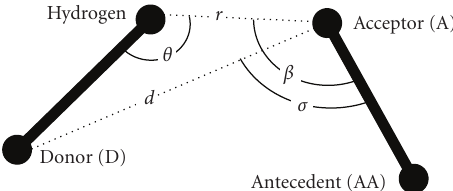
Figure 2: Hydrogen bond geometrical structure scheme. The distance (d) between a donor (D) and an acceptor (A) and the resulting angles σ , β , θ and σ are reported.